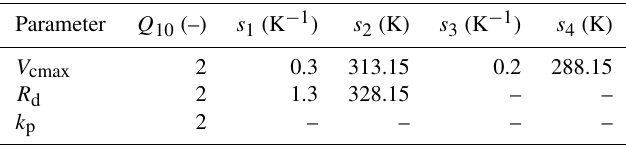
Table B2. C 4 temperature dependence functional